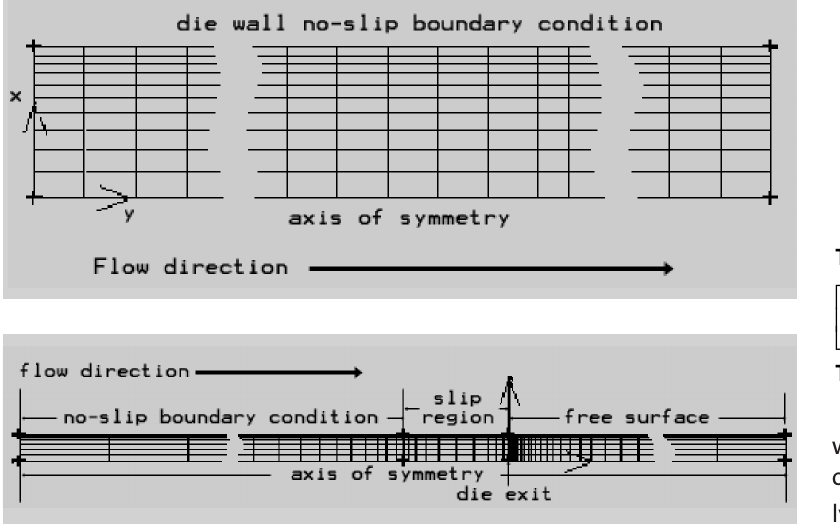
Figure 4 (left above): Mesh design for a) stress relaxation simulation and b) extrudate swell simulation.